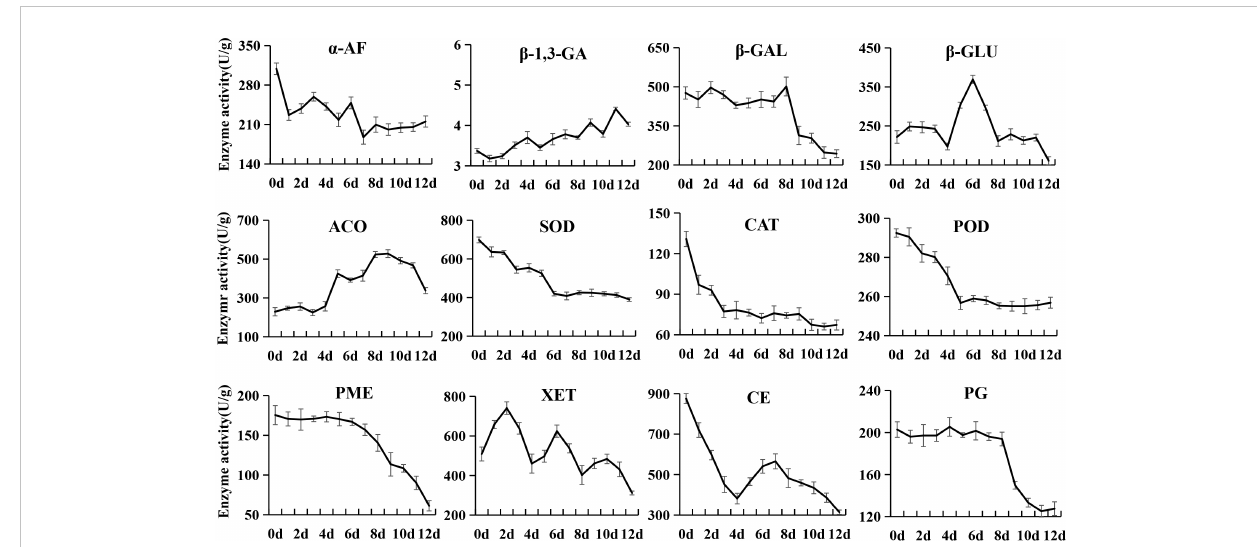
FIGURE 6 Changes in enzyme activities related to the softening of kiwifruit during postharvest ripening. The error bars represent the SD from three